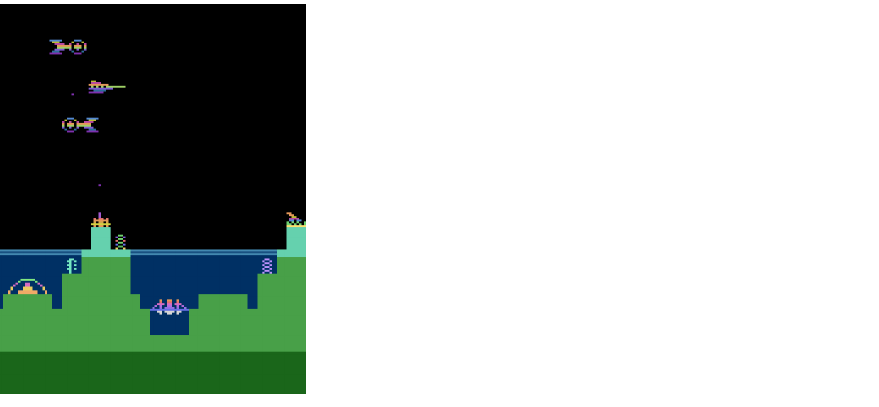
Figure 9. Atari game Atlantis, in which dueling Q–network outperformed the classic DQN by 296%. Image taken using the OpenAI Gym Python package